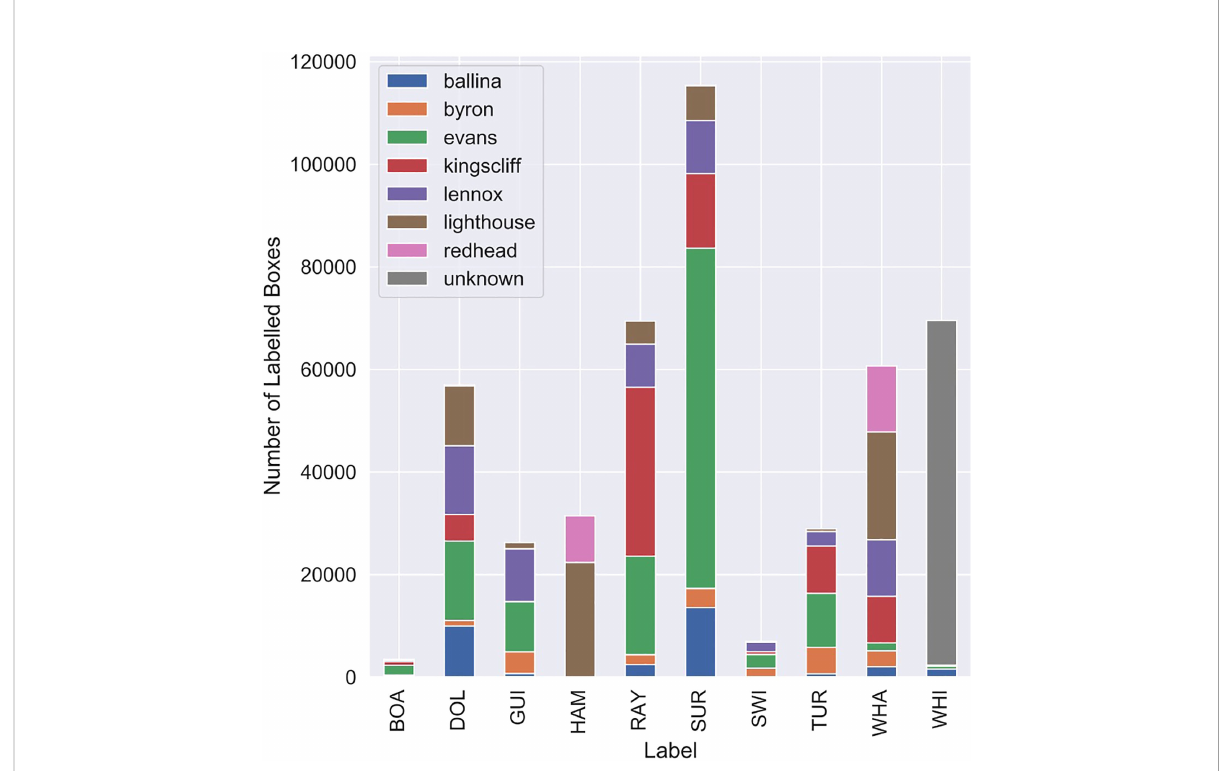
FIGURE 4 Distribution of sampled bounding boxes over the ten classes of interest, divided by sampling